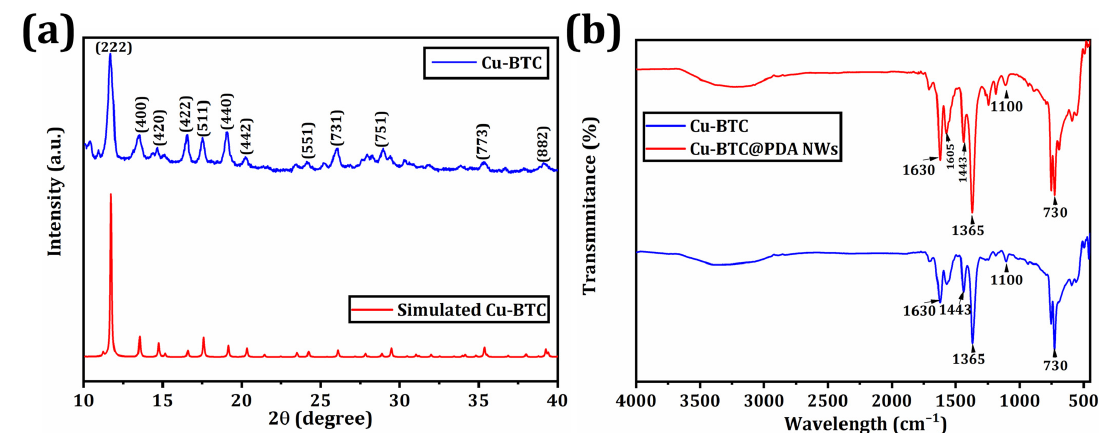
(26.2%), carbon (32.1%), and oxygen (41.7%). These findings suggest the successful for- Figure 2. ( a ) XRD analysis of NWs. ( b ) FTIR analysis of NWs. Figure 2. ( a ) XRD analysis of NWs. ( b ) FTIR analysis of NWs. mation of Cu-BTC NWs.